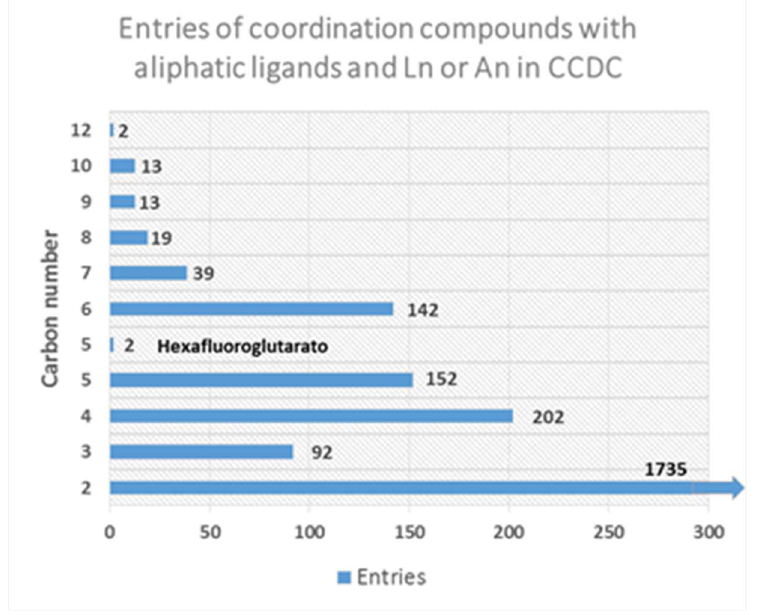
Figure 1. Entries distribution in the CCDC for compounds with aliphatic ditopic ligands and Ln or An metals.